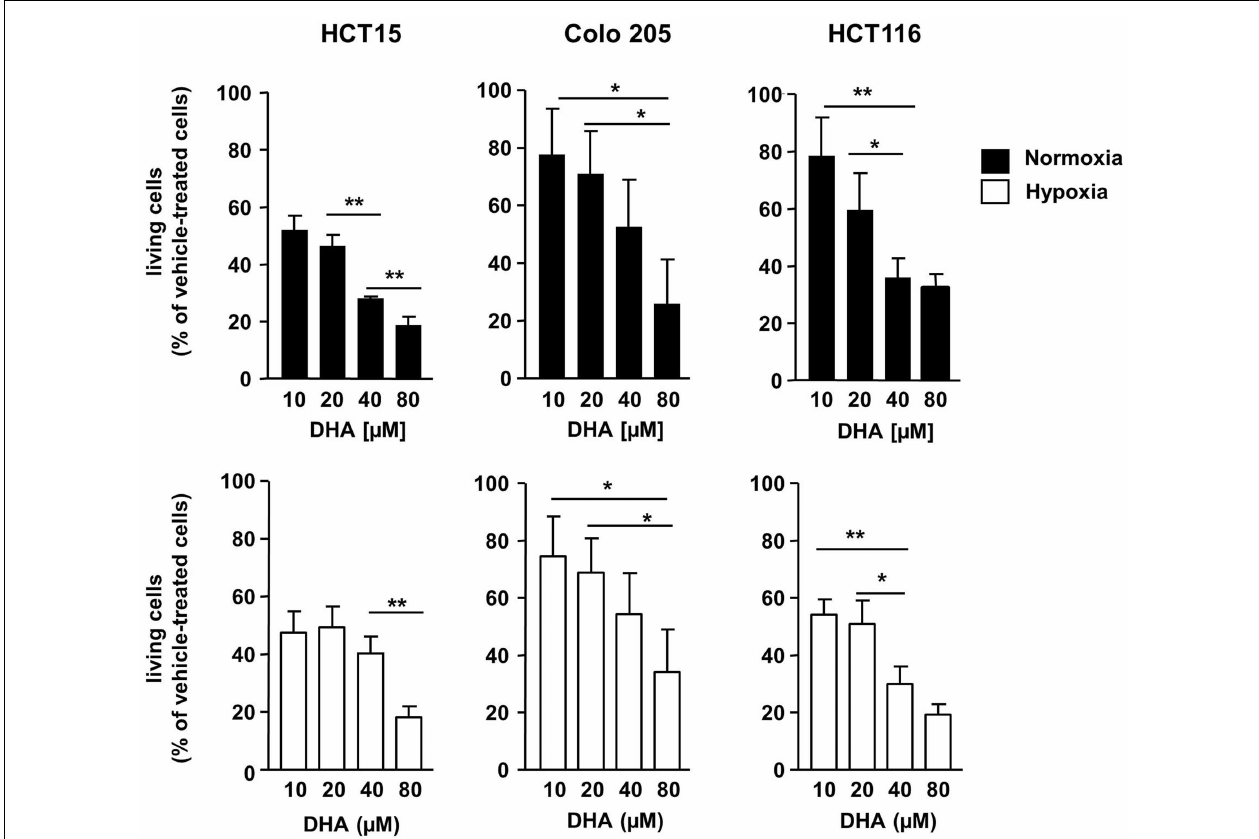
solvent control. DHA reduces the number of viable HCT15, HCT116, and Colo 205 cells in a concentration-dependent manner in normoxia